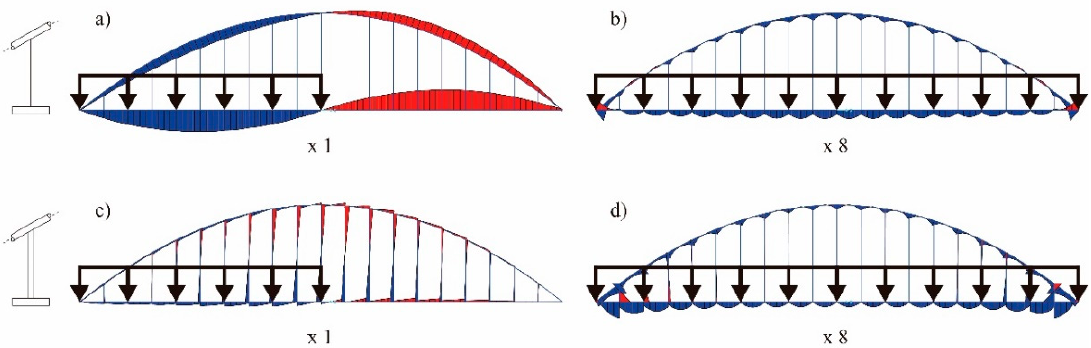
Figure 8. Bending moment diagrams for pinned and fixed stiff hangers (800 × 800 × 20 mm). Live load distributed on half deck, q 1 ( a , c ), and the whole deck, q 3 ( c , d ), both for cables ( a , b ) and stiff hangers ( c , d ).